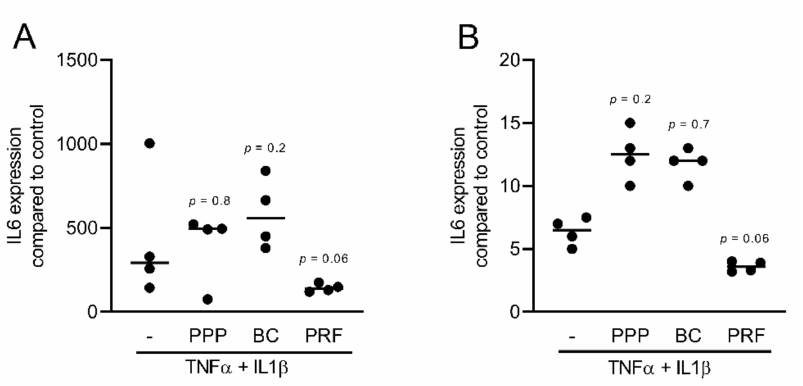
Figure 4. PPP, BC, and PRF lysates reduced inflammation in murine calvaria-derived cells. Calvaria cells were exposed to 10% of PPP, BC, and 30% of PRF in the presence of the inflammatory cytokines TNF α and IL1 β . ( A , B ) Data indicate the x-fold changes of iNOS and CCL5 gene expression, n = 4.